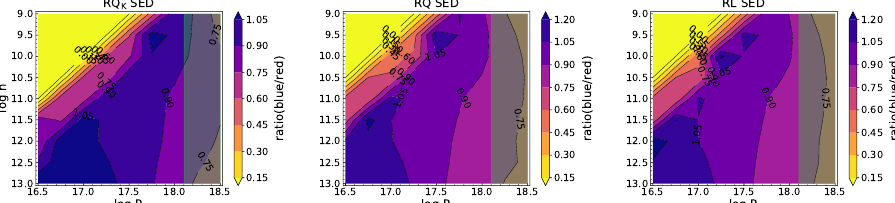
Figure 12. Results of CLOUDY simulations: the three panels yield the ratio R FeII B to R FeII R (in practice B/R) as a function of density and BLR radius, for the RQ Korista et al. [89] ( leftmost ), the RQ Laor et al. [104] ( middle ) and RL SED ( rightmost